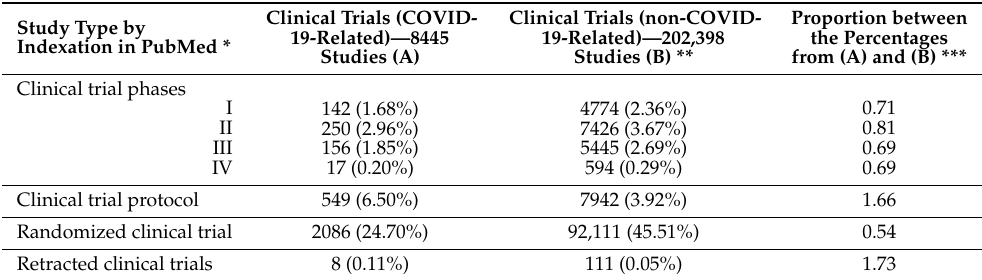
Table 1. Number of clinical trials published in PubMed during the Coronavirus Disease (COVID)-19 pandemic and the proportion between COVID-19-related clinical trials and other clinical trials. Study Type by Indexation in PubMed